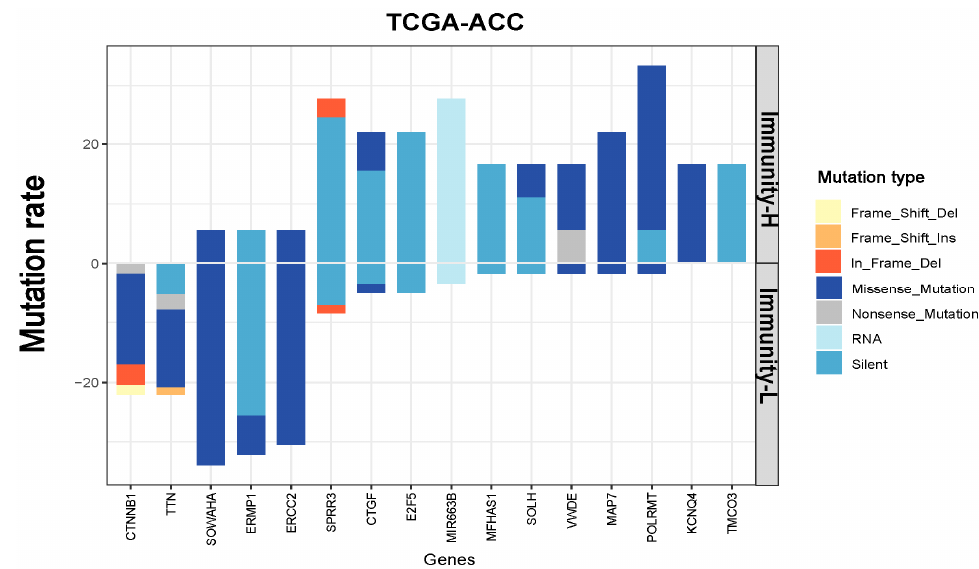
Figure 4. Different mutation rates between the immune subtypes of ACC. Eleven genes more frequently mutated in Immunity-H than in Immunity-L ACC (Fisher’s exact test, p <